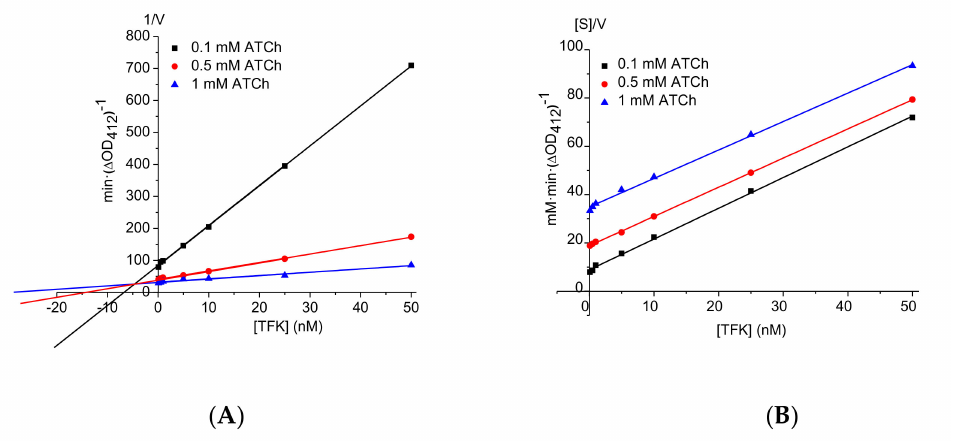
Figure 3. Dixon plot ( A ) and Cornish-Bowden plot ( B ) for determination of fast reversible inhibition constant. The plots of k obs vs. [TFK] were built for each ATC concentration (Figure 4). This diagnosis plot established the type of